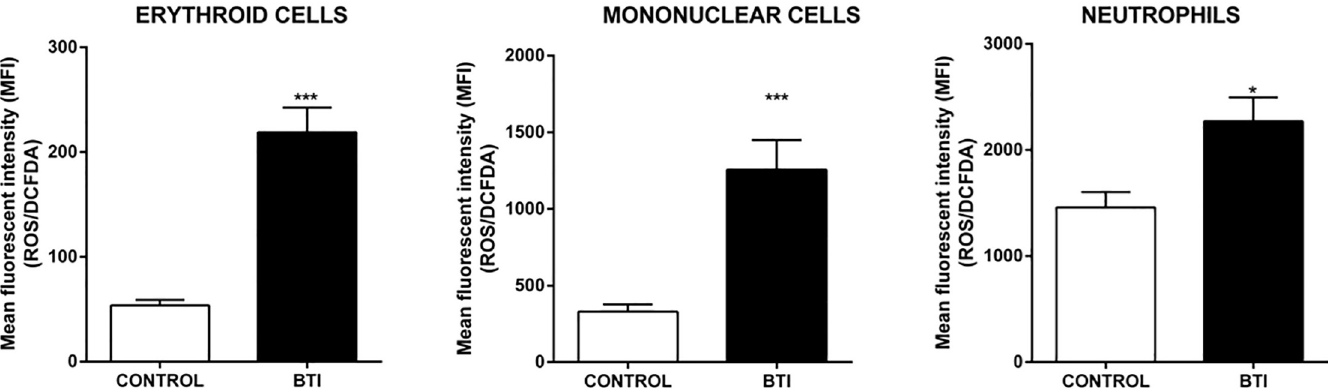
Fig 1. ROS production was increased in different cell types of patients with β Thalassemia intermedia. Analysis of DCFDA fluorescence intensity, corresponding to the level of ROS production in erythroid, mononuclear and neutrophils cells. The results are expressed as mean ( ± SEM) fluorescence intensity (MFI) emitted by the analyzed cells of control and BTI patients. Statistical difference: ( � ) p < 0.05 and ( ��� ) p < 0.001.